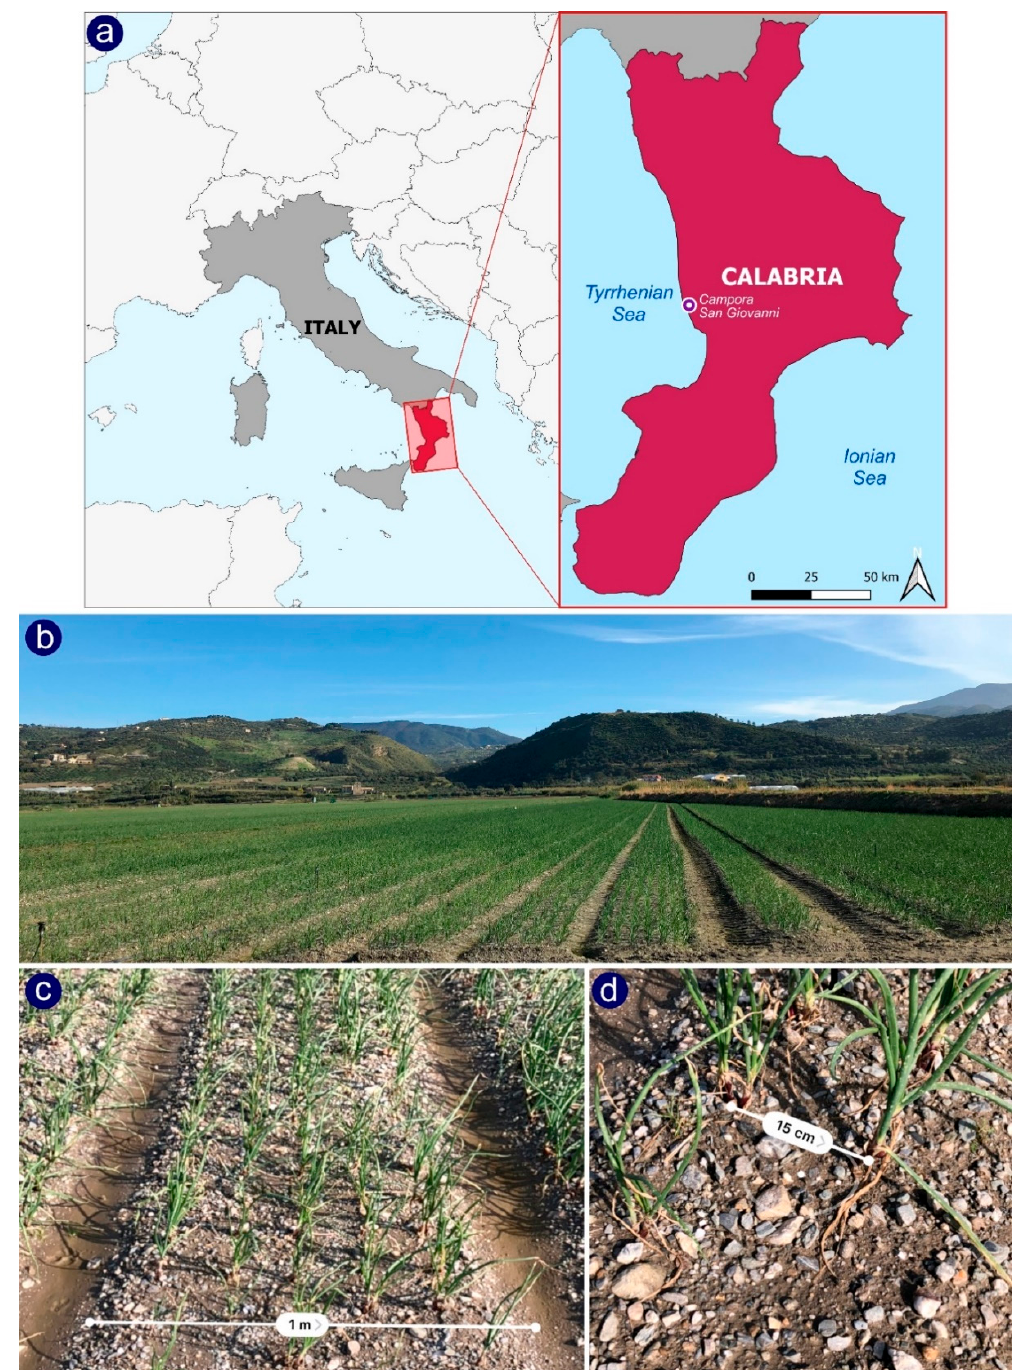
Figure 1. ( a ) The location of the study site. ( b,c,d ) The onion field in which the surveys were carried out (Campora S. Giovanni, CS –